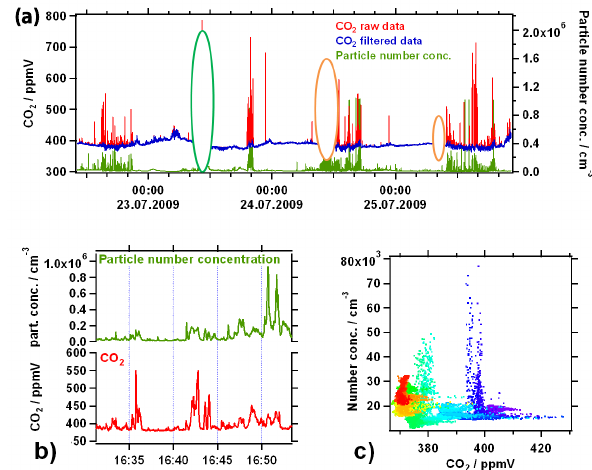
Fig. 9. Time series of mobile and intermediate stationary over-night particle number concentration and CO 2 data from the MEGAPOLI summer field campaign in July 2009. The raw data (red and green traces) show many short peaks due to local contamination sources, which are efficiently removed in the filtered CO 2 data (blue trace) using the contamination identification algorithm (a) . The zoom-in (b) shows 20min of high time resolution data from 20 July. Some of the contamination peaks appear mainly in the CO 2 time series, others mainly in the particle number concentration data, resulting in separated branches in the scatter plot ( c , color-coded by mea- surement